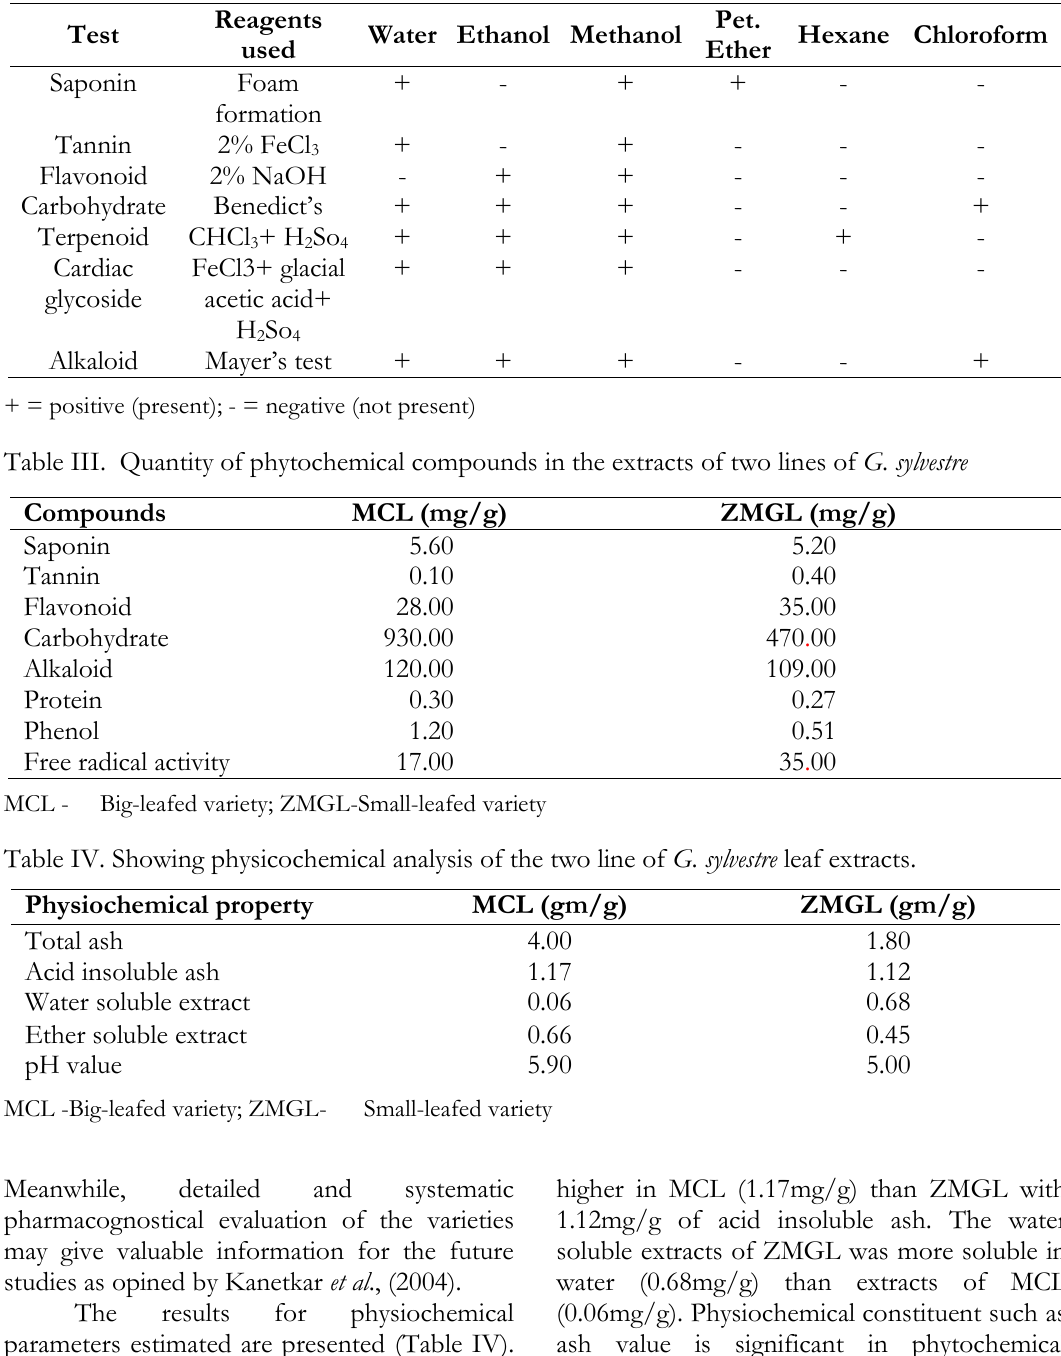
Table II. Showing presence or otherwise of phytochemical compounds in the leaves extract of G. sylvestre using different solvents.